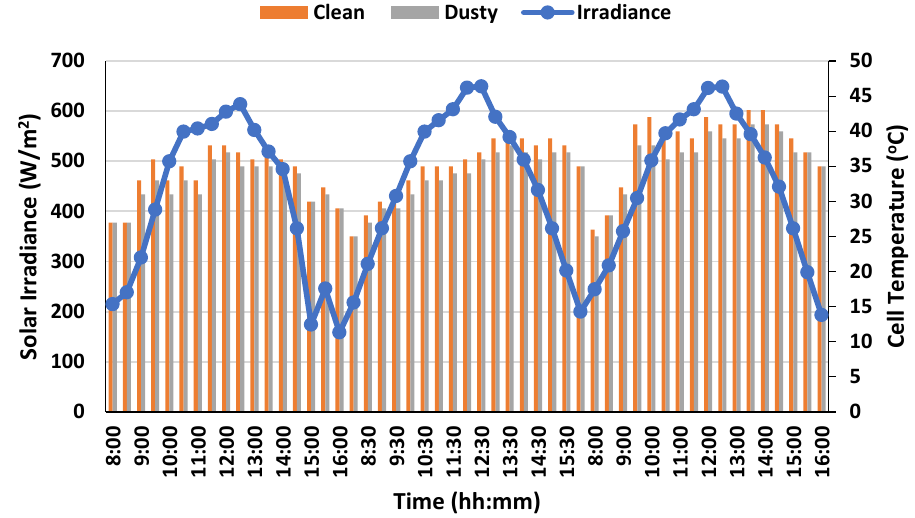
Figure 8. Effect of solar cell temperature considering dust on the PV module.